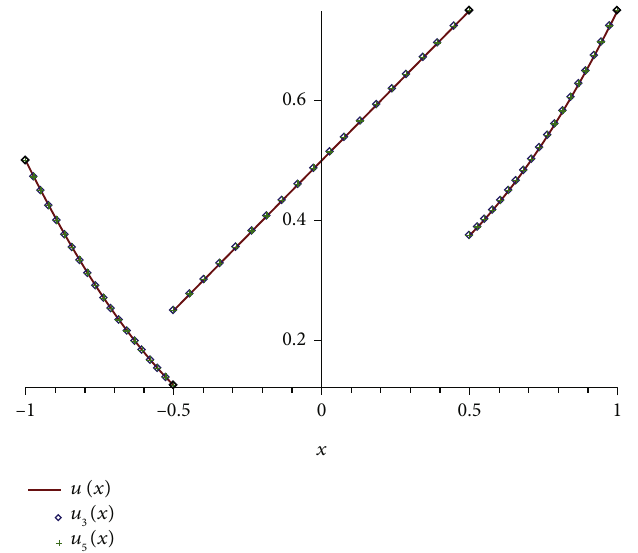
ð x Þ , u ð x Þ for Example 5. 3 5